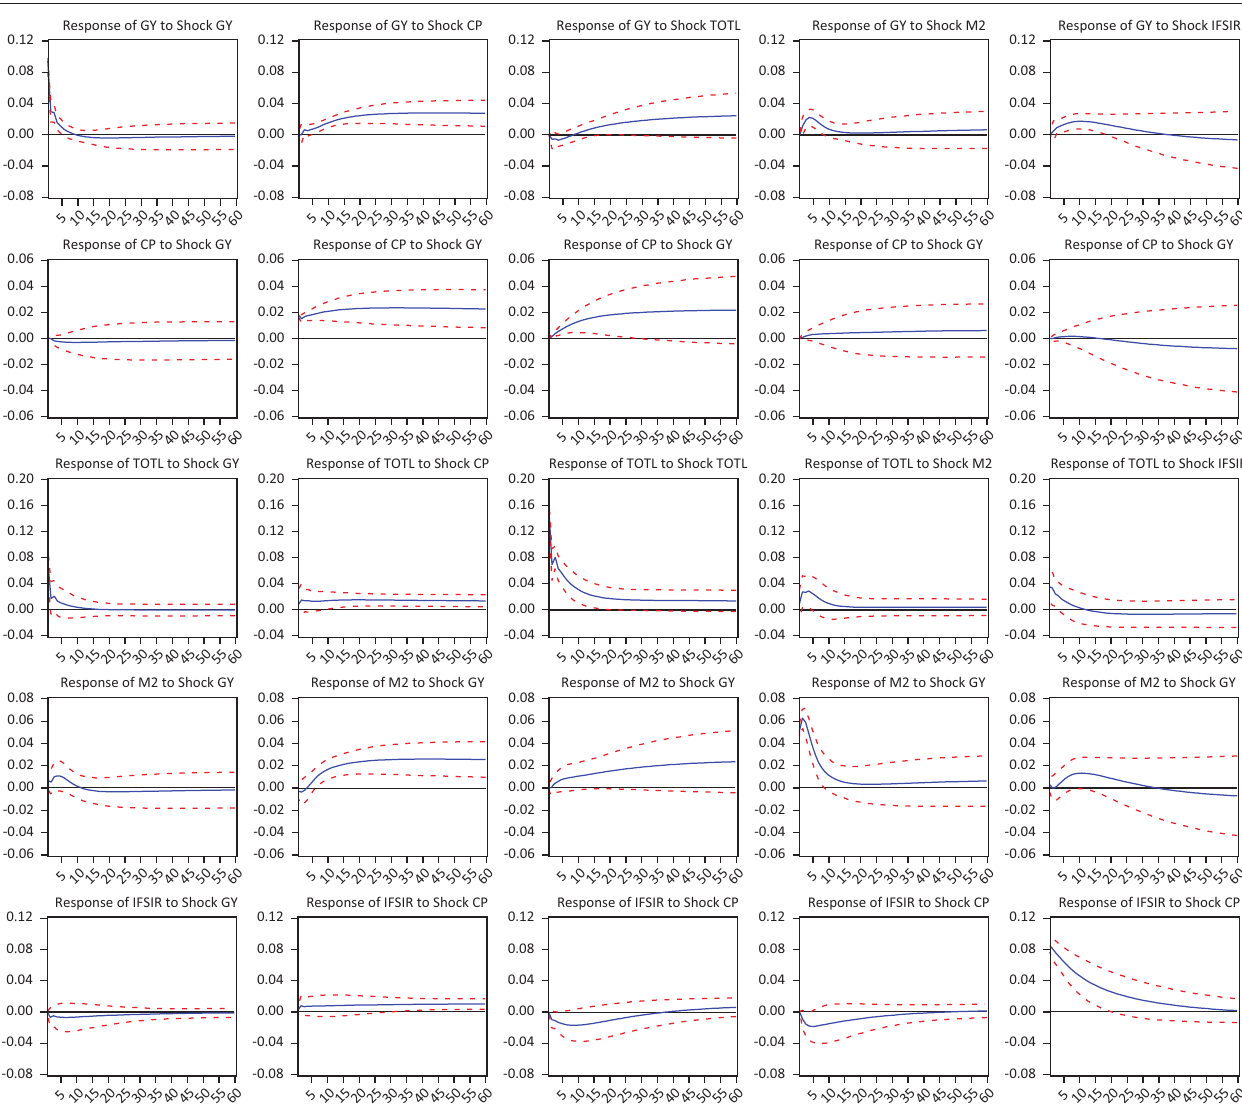
FIGURE 5-A1: Impulse responses with informal financial sector interest rates and total credit (aggregated formal and informal financial sector